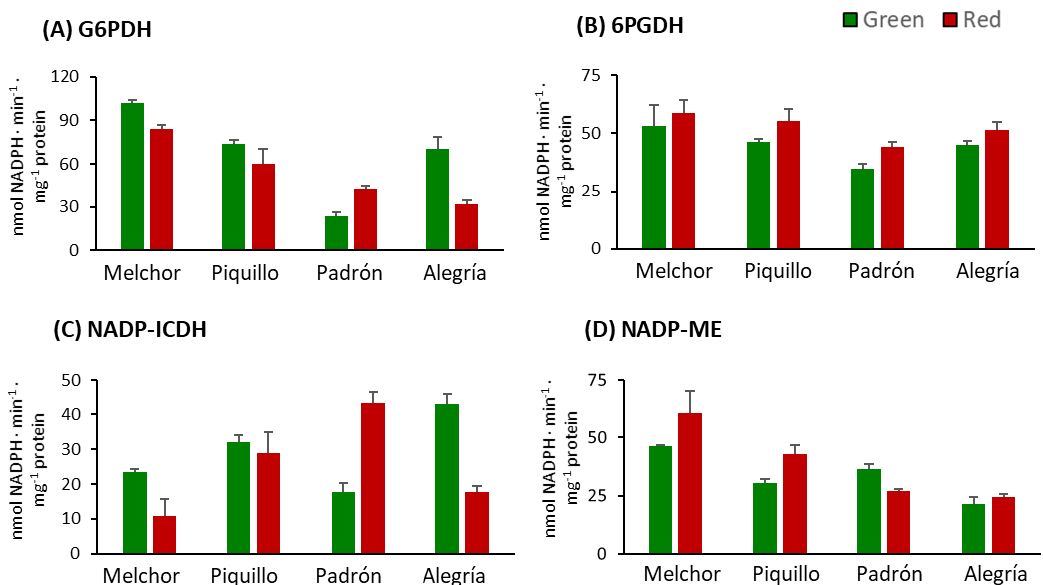
Figure 7. Activity of NADP-dehydrogenases in pericarp from fruits of four pepper varieties at two ripening stages. ( A ) Glucose-6-phosphate dehydrogenase (G6PDH). ( B ) 6-Phosphogluconate dehydrogenase (6PGDH). ( C ) NADP-dependent isocitrate dehydrogenase (ICDH). ( D ) NADP-dependent malic enzyme (ME). Data are the means ± SEM of three replicates determined from five fruits of the four varieties and at the two ripening stages. Asterisks indicate significant differences of red fruits with respect to green fruits for each variety ( t -student, p < 0.05).